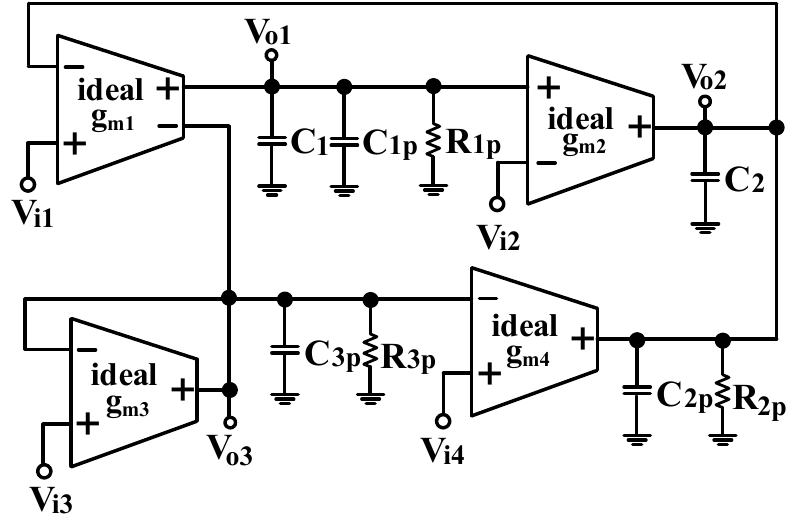
Figure 6. Proposed versatile VM biquad filter including the parasitic components of OTAs.